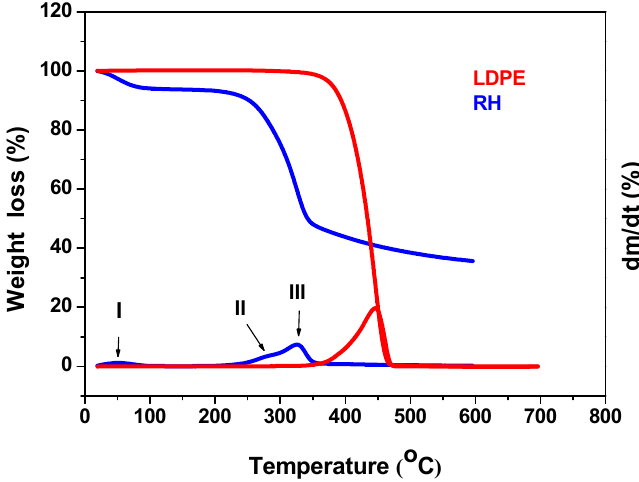
Figure 8. TGA curves of the neat LDPE and RH at a heating rate of 10 °C min –1 . The initial weight loss of the neat LDPE occurred in a single stage of degradation from 458 to 504 ◦ C. According to Kim et al., the thermal degradation of LDPE can take place through random chain scission and a radical chain mechanism [31]. The radical mechanism for polyethylene involves the formation of free radicals and abstraction of hydrogen from the polymer chains leading to a molecular weight decrease and, finally, to the formation of volatile products. Polyethylene decomposes into a large number of paraffinic and olefinic compounds without residue [32]. Figure 9 shows the TG of the neat LDPE and LDPE/RH biocomposites, while Table 4 depicts the thermal decomposition data of all samples, including initial degradation temperature ( T 0 ), end temperature ( T end ) and the percentage residue at 600 ◦ C.